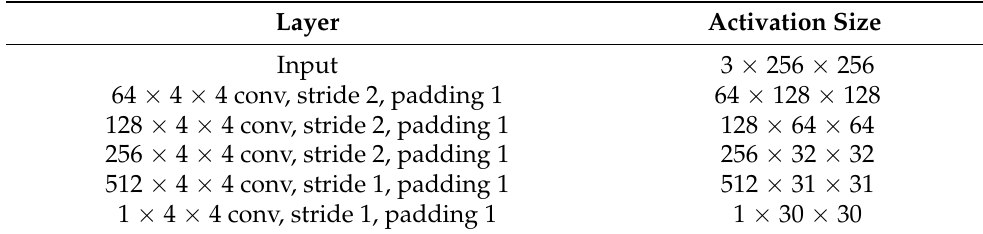
Table 2. Architecture of discriminator